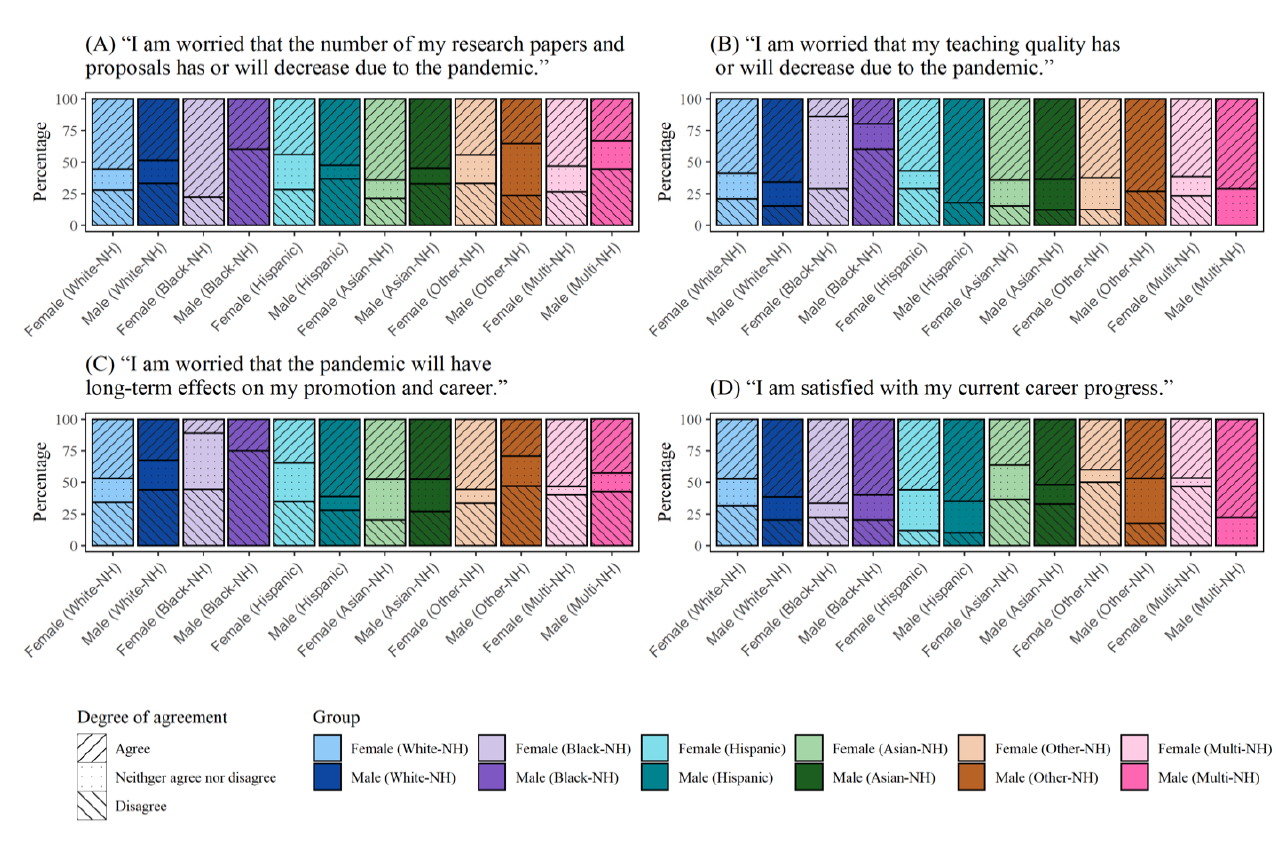
Figure 3. Degree of agreement on the impacts of the COVID-19 pandemic on work and career progress, by gender and race/ethnicity. Note. NH = non-Hispanic.